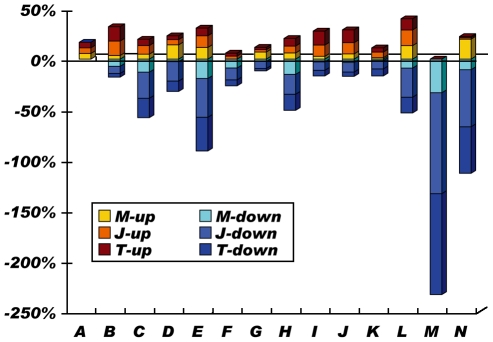
Statistic analysis of the leptospiral transcriptional regulation based on KEGG pathway.The percentage of differentially regulated genes was calculated by dividing the number of up-regulated or down-regulated genes by the total number of genes in each category, respectively. A, Biosynthesis of Polyketides and Nonribosomal Peptides (9 genes); B, Biosynthesis of Secondary Metabolites (28 genes); C, Carbohydrate Metabolism (224 genes); D, Cell Motility (78 genes); E, Energy Metabolism (78 genes); F, Folding, Sorting and Degradation (34 genes); G, Glycan Biosynthesis and Metabolism (43 genes); H, Lipid Metabolism (132 genes); I, Membrane Transport (36 genes); J, Metabolism of Cofactors and Vitamins (117 genes); K, Replication and Repair (72 genes); L, Signal Transduction (45 genes); M, Transcription (3 genes); N, Translation (76 genes). M-up, J-up, and T-up: the percentages of up-regulated genes in M, J and T samples; M-down, J-down, and T-down: the percentages of down-regulated genes in M, J and T samples. A gene regulated either at a time-point or at two time-points was included in this statistics analysis. If a gene was up-regulated at a time-point but down-regulated at another time-point, it was included both in up-regulation and in down-regulation.